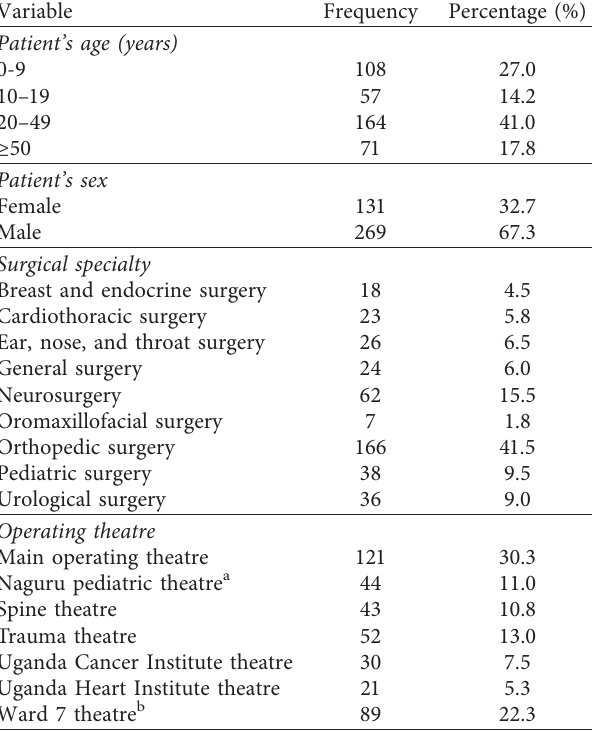
Table 1: Baseline characteristics of 400 patients scheduled for elective procedures in surgical wards at Mulago Hospital,